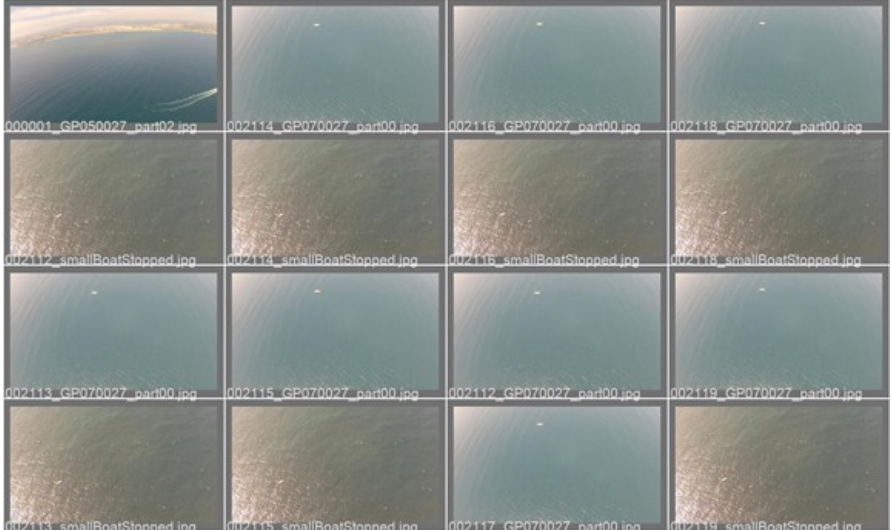
Figure 8. Examples of annotated images in the test set from SEAGULL—the pretrained algorithm failed to predict bounding boxes in all test